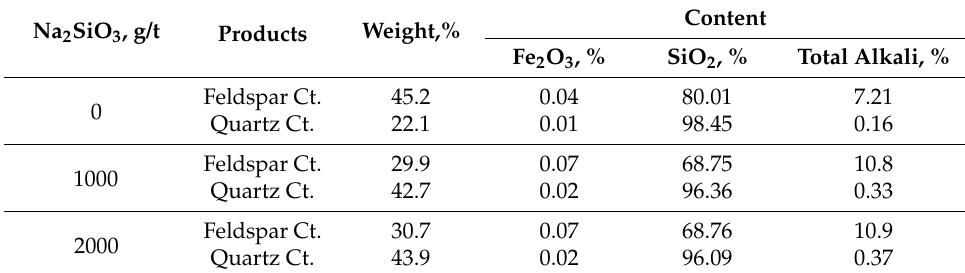
Table 3. The results of flotation tests for evaluating the influence of sodium silicate addition (Ct: concentrate). Na 2 SiO 3 ,